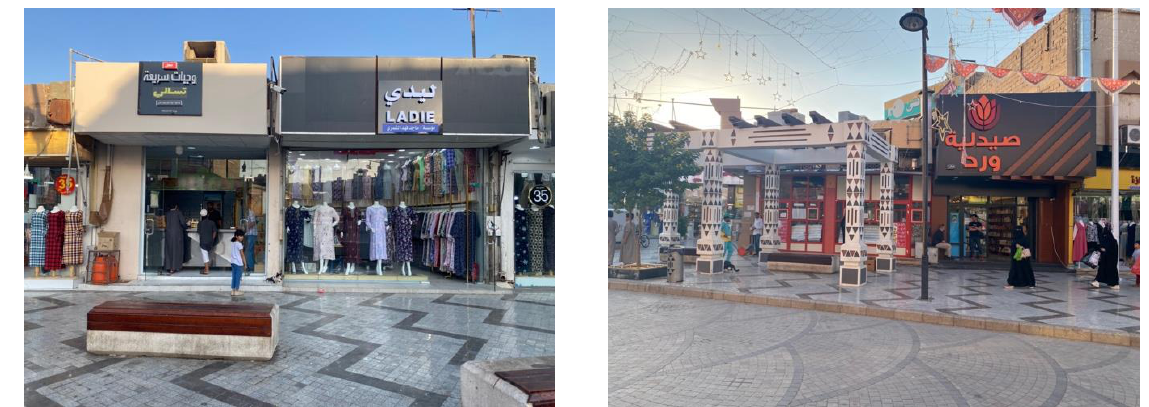
Figure 14. Overlapping of food places and architectural elements with the shop’s storefronts.